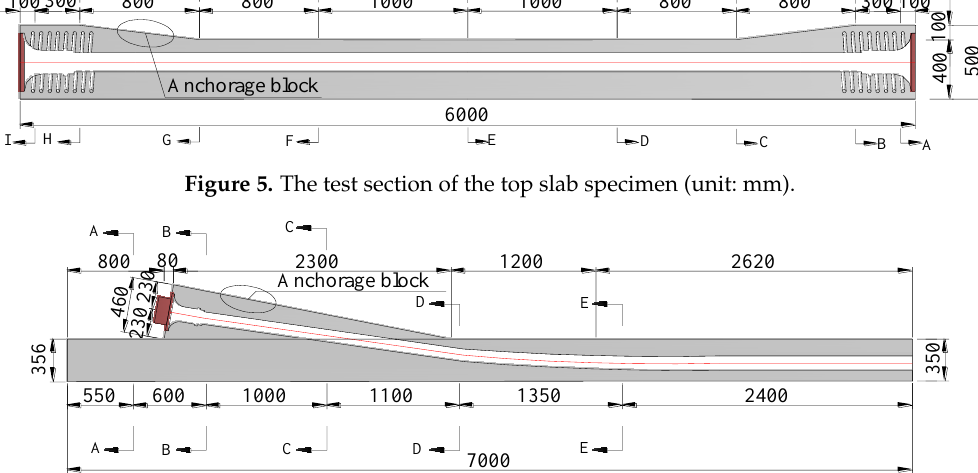
Figure 6. The test section of the bottom slab specimen (unit: mm)